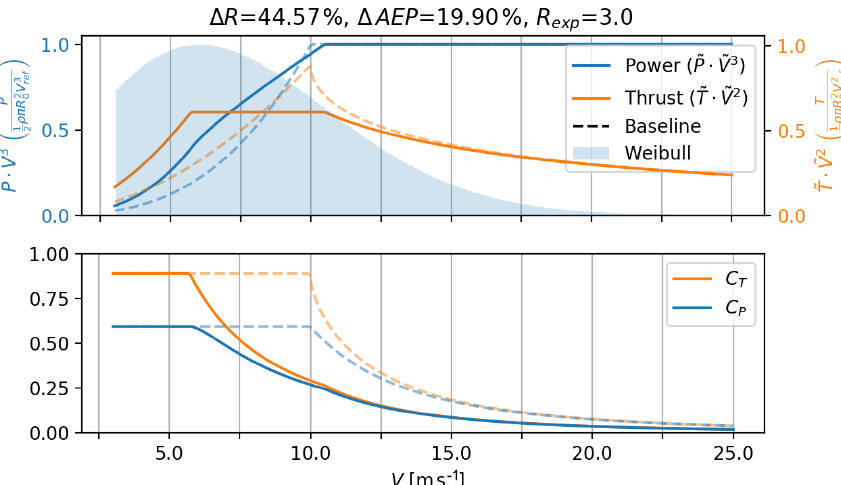
Figure 10. Power and thrust curve for an AEP-optimized rotor (solid lines) where the DDLC exponent is R exp = 3, which is equivalent to a constraint on M flap . The dashed line is the baseline rotor optimized for the max C P below the rated power.